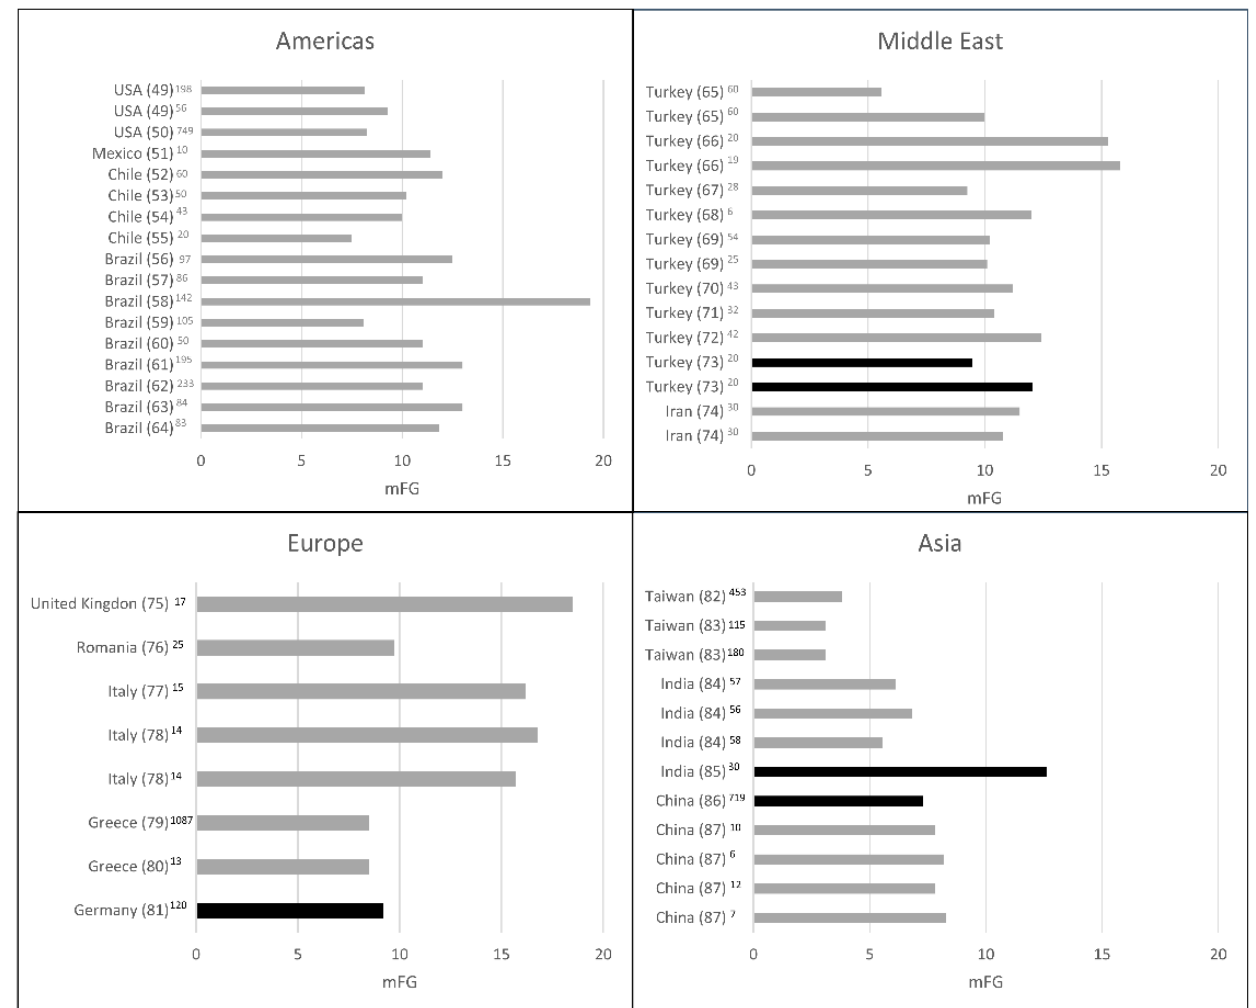
Figure 2. Hirsutism scores in women with polycystic ovary syndrome (PCOS) according to geo- graphic distribution. PCOS was diagnosed by the Rotterdam, US National Institutes of Health (NIH), or Androgen Excess Society (AES) criteria. Black lines indicate unselected studies. Superscript numbers indicate sample size. mFG: modified Ferriman–Gallwey score.